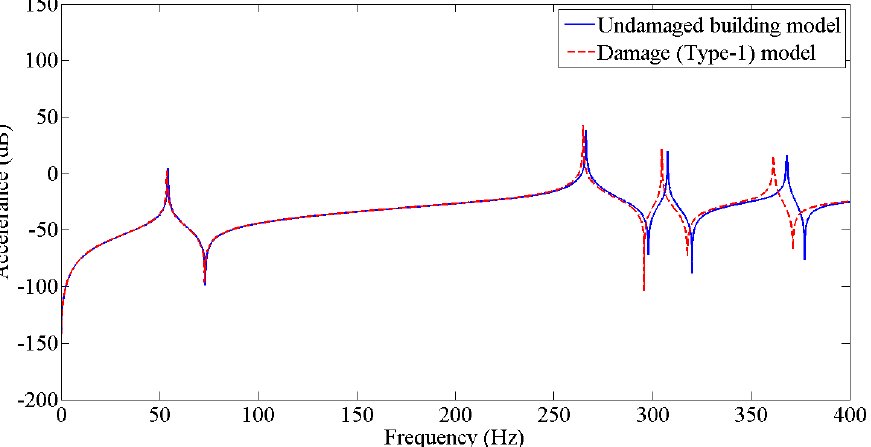
Figure 6. Prediction of structural dynamic behavior of building model under undamaged and damaged (Type − 1) conditions through FRFs.